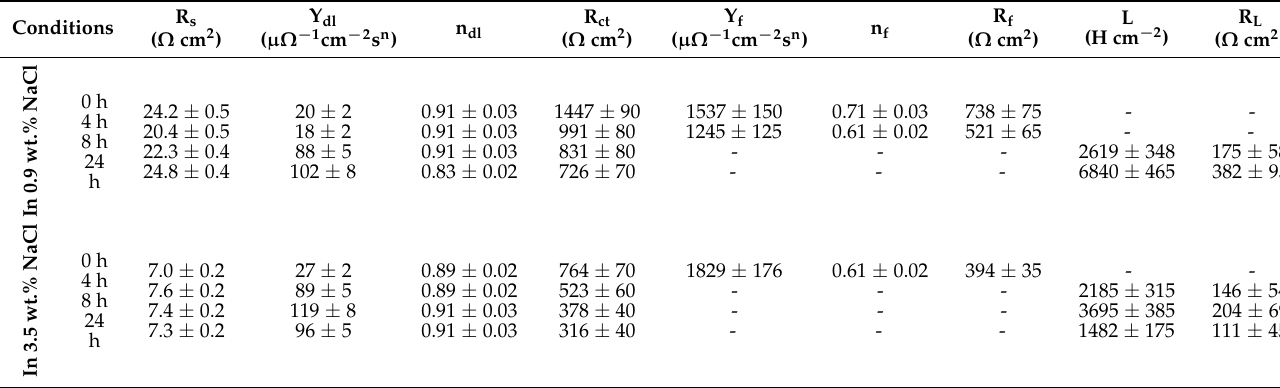
Table 3. The fitted EIS data on the basis of the equivalent circuits.